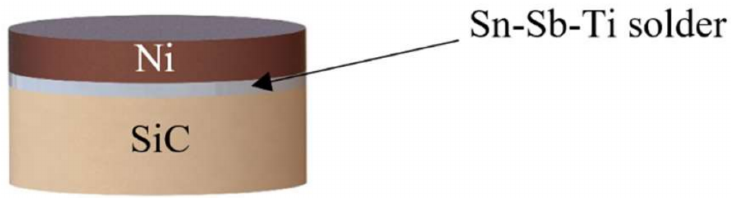
Figure 1. Assembly of a soldered joint for the analysis of solder/substrate